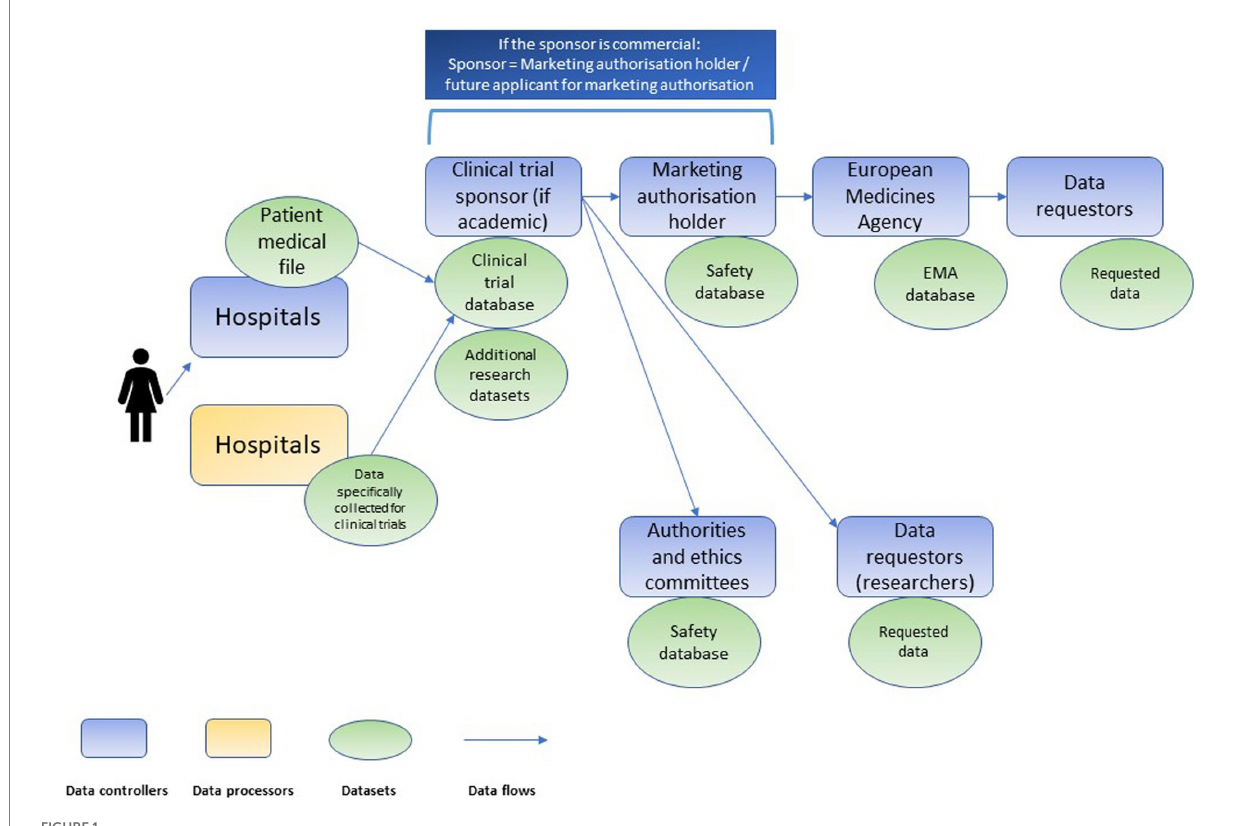
FIGURE 1 Chain of independent data controllers in clinical trials, adapted from Negrouk et al. (26).